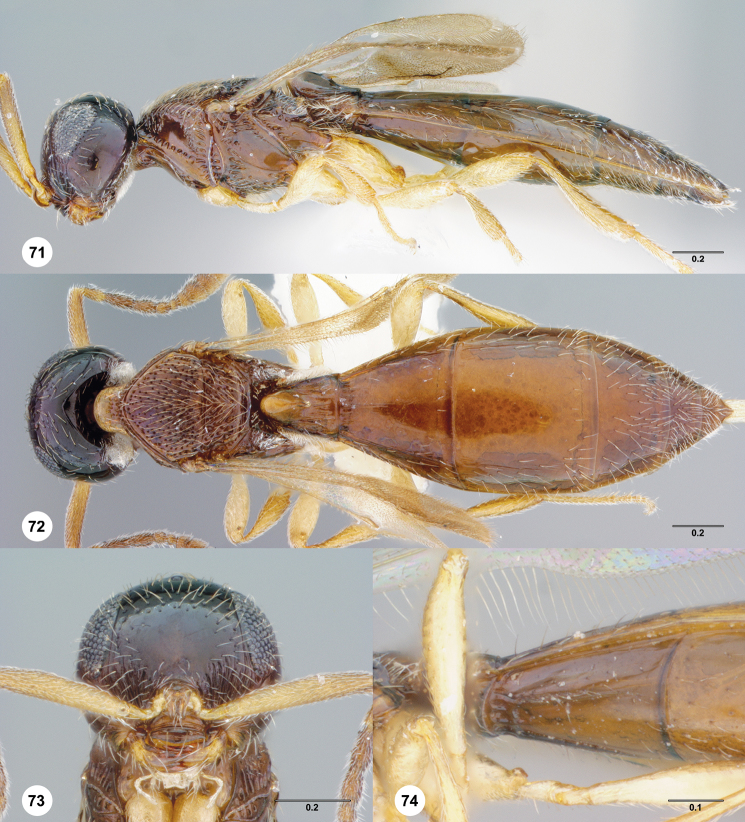
95
Paridris saurotos, sp. n. 71 Lateral habitus, female holotype (OSUC 262111) 72 Dorsal haitus, female (OSUC 265171) 73 Head, anterior view, female (OSUC265171) 74 S2, ventrolateral view, female (OSUC 262107)